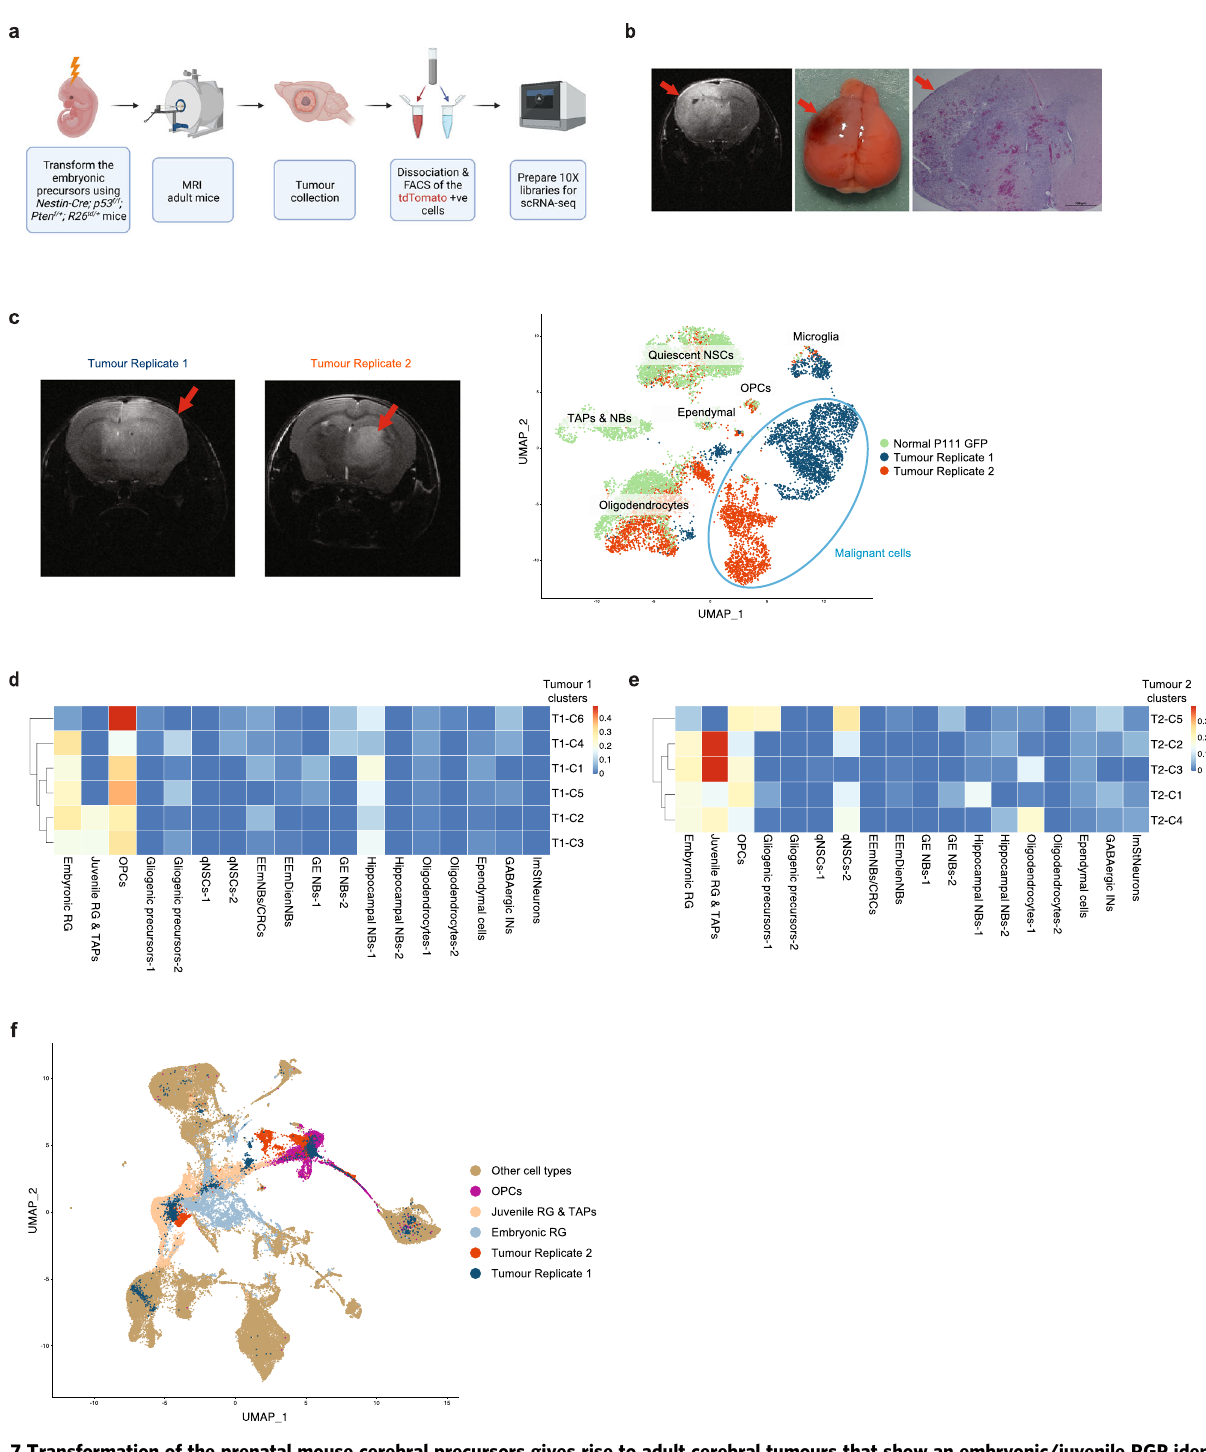
Fig. 7 Transformation of the prenatal mouse cerebral precursors gives rise to adult cerebral tumours that show an embryonic/juvenile RGP identity. a Schematic overview of the experimental work fl ow. b , MRI of a mutant mouse brain at 16 weeks of age showing a tumour encompassing the left hemisphere (red arrows) with an image of the brain after dissection and an H&E-stained section. The brain was collected 30 min after the MRI. Scale bar, 100 µ m. c Left: mouse brain MRI from two tumour replicates, the scans were performed 30 min before brain sample collection. Shown on the right is the UMAP clustering of single-cell transcriptomes from the two mouse tumour replicates and the GFP + cells from the P111 timepoint in the developmental atlas. d , e Deconvolution analysis heatmap of the malignant clusters from tumour replicate 1 ( d ) and tumour replicate 2 ( e ), showing relative fraction of the mouse developmental cell-types for each tumour cluster (see Methods). The malignant cells from each tumour replicate were clustered separately (see Supplementary Fig. 10b, c and Methods) and the clusters are denoted as e.g., “ Tumour-replicate#1 cluster#1 ” = “ T1-C1 ” . f Co-clustering of the cells from the two tumour replicates with the clusters from the mouse developmental dataset (see Methods). Abbreviations as in Fig.